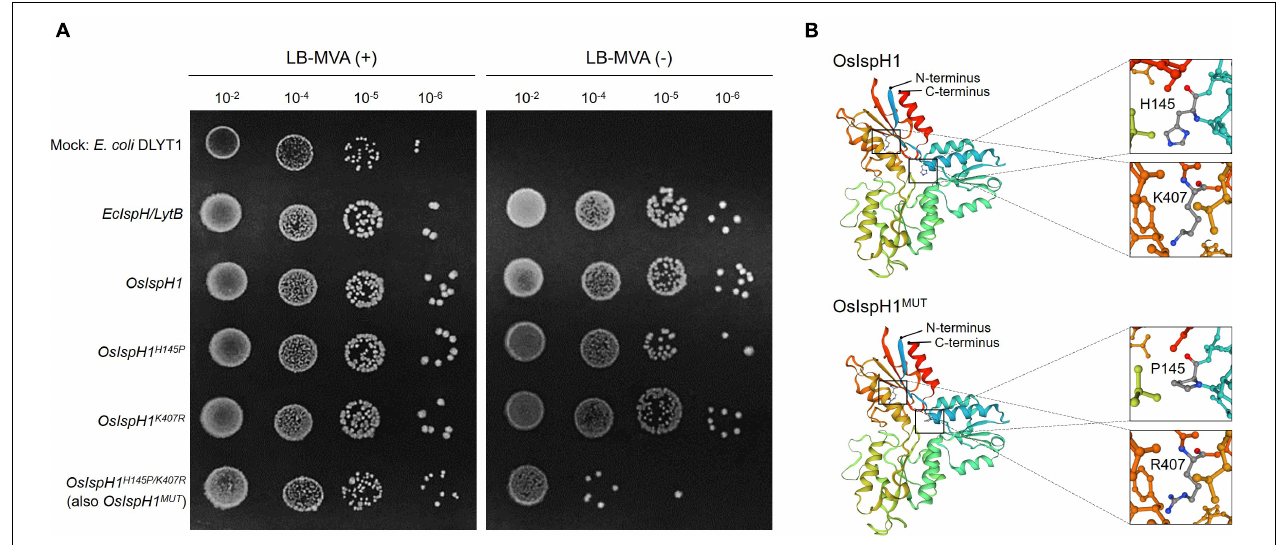
FIGURE 4 | The 4-hydroxy-3-methylbut-2-enyl diphosphate reductase (HDR) enzyme assay in an Escherichia coli system and simulated protein structures of IspHs. (A) Functional complementation in E. coli DLYT1, an EcIspH lesion strain. An E. coli IspH gene, EcIspH / LytB , was used as a positive control. Mevalonate (MVA) (+) and (-) mean 0.01% and none of mevalonolactone, respectively. (B) Simulation of the 3D modeling to predict protein structure as rainbow ribbon drawing based on PDB ID: 3DNF from Aquifex aeolicus IspH built using SWISS-MODEL. Enlarged views showed the region with H145 and K407 residues as a ball and stick model with carbon (gray), nitrogen (blue), and oxygen (red)